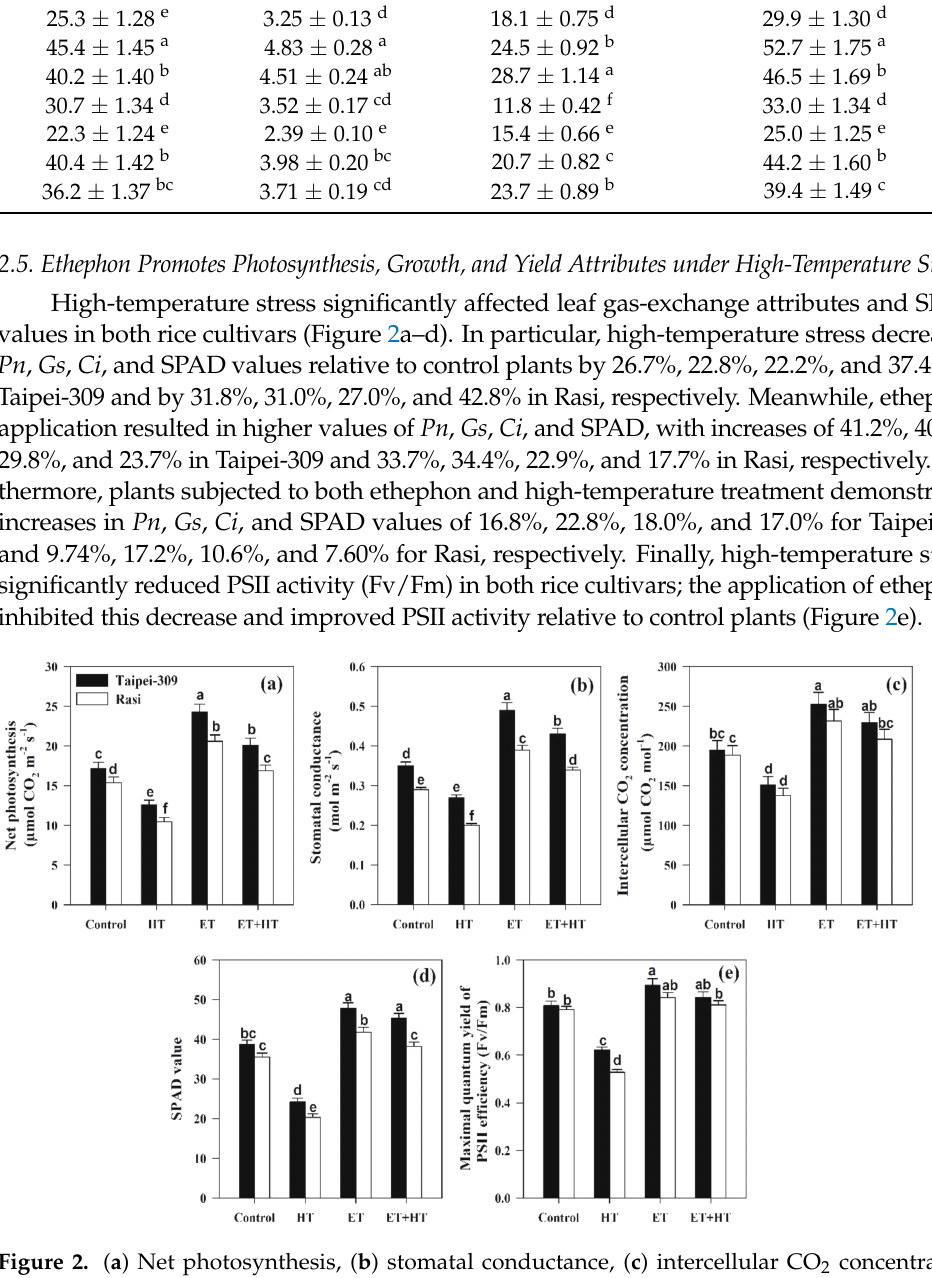
Figure 2. ( a ) Net photosynthesis, ( b ) stomatal conductance, ( c ) intercellular CO 2 concentration, ( d ) SPAD value, and ( e ) maximal quantum yield of PSII efficiency (Fv/Fm) in Taipei-309 and Rasi cultivars of rice ( Oryza sativa L.) at 30 DAS. Plants were grown with/without high-temperature (HT) stress and treated with a foliar spray of 1.6 mM ethephon (ET) at 15 DAS. Data are presented as treatment means ± SE ( n = 4). Bars with the same letters did not differ significantly by the LSD test at p < 0.05. DAS, days after